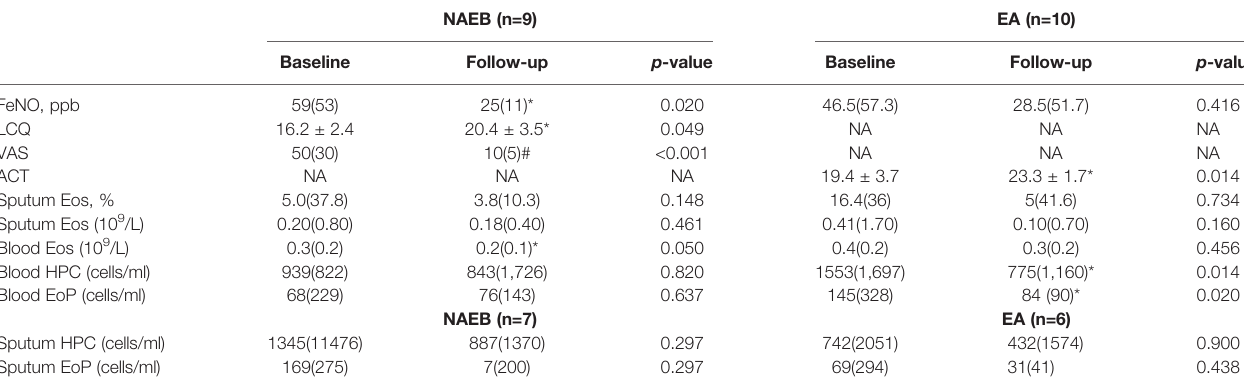
TABLE 2 | Changes of biomarkers after one-month treatment in NAEB and EA Group. NAEB (n=9) EA (n=10) Baseline Follow-up p -value Baseline Follow-up p -value FeNO,